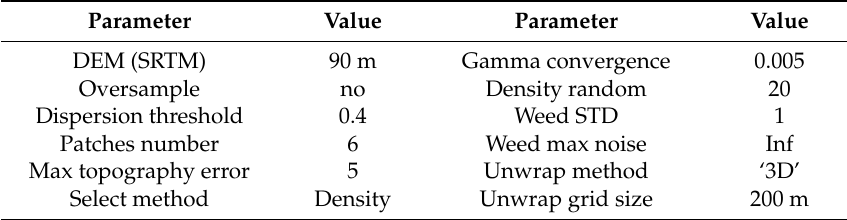
Table 2. StaMPS processing